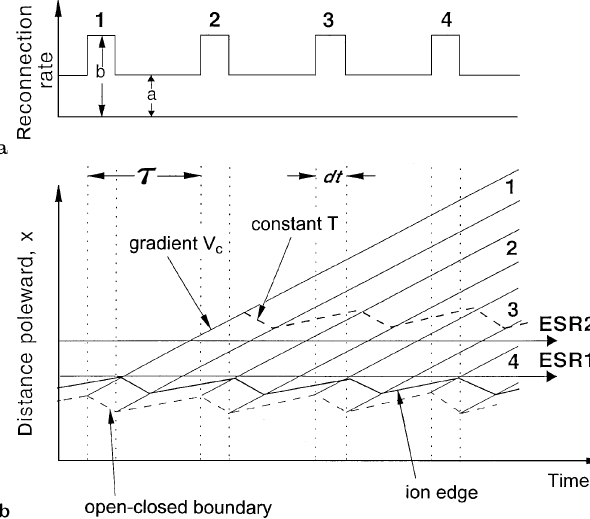
Fig. 7. Same as Fig. 1, but for a / b "